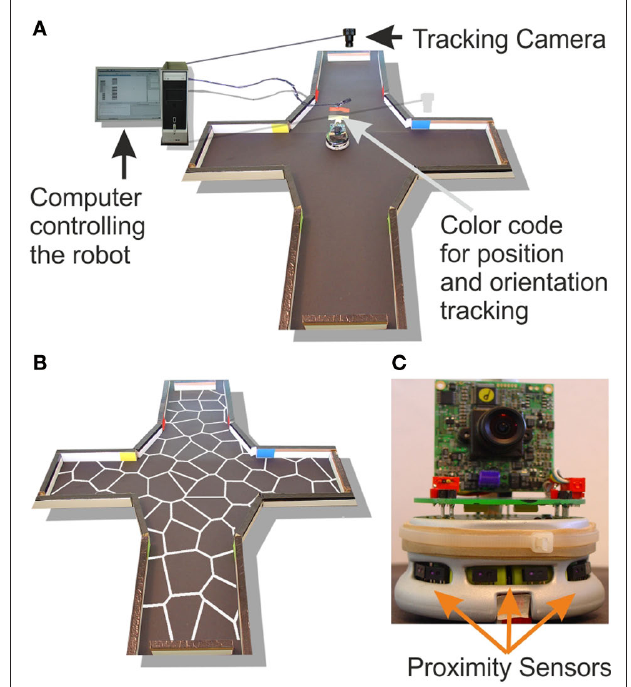
Figure  | (A) A four-arm-maze environment was chosen to test the model. A Khepra robot was controlled by an agent implemented in the MicroPsi framework, running on a computer. The inputs to the program were the orientation and the position of the robot, as well as the data from the proximity sensors. (B) shows the distributions of states used. The white lines within the environment represent the boundaries of these states. (C) shows these proximity sensors on the robot. These sensors emit infrared light and measure the reflection. The agent used the activation of the place cells which corresponded to its current position, the orientation of the robot, and the proximity sensors to perform the robot’s